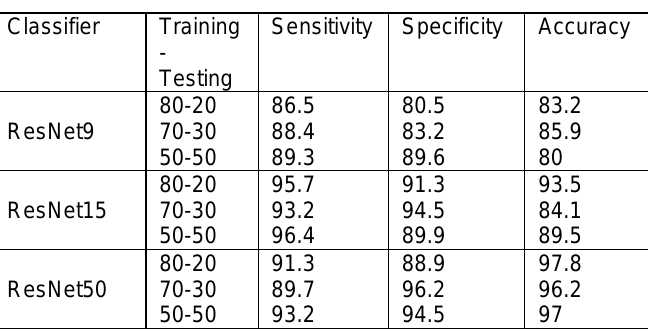
Table 1. Different Neural Networks with